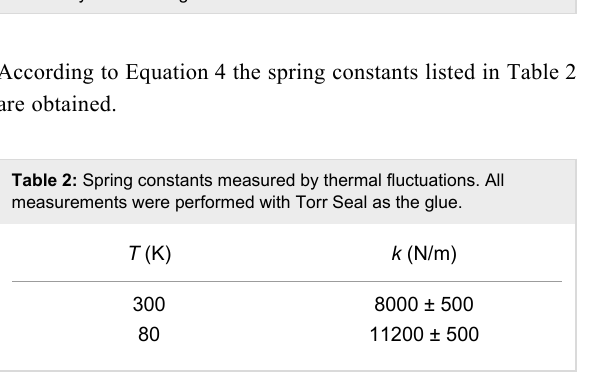
Figure 4: Power spectral density of the thermal fluctuations of a tuning fork at 300 and 80 K. The inset shows the data used to calibrate the sensitivity of the tuning fork.